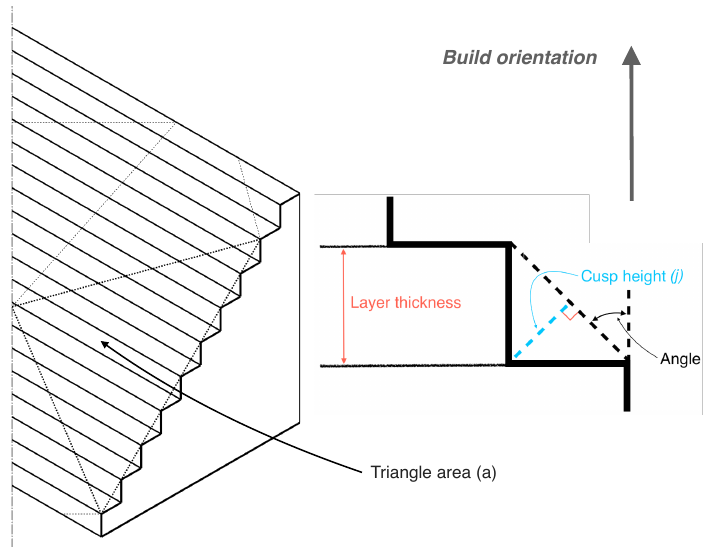
Figure 7. Cusp height, generated by difference between the nominal and real model, as simple and analytic evaluation of surface